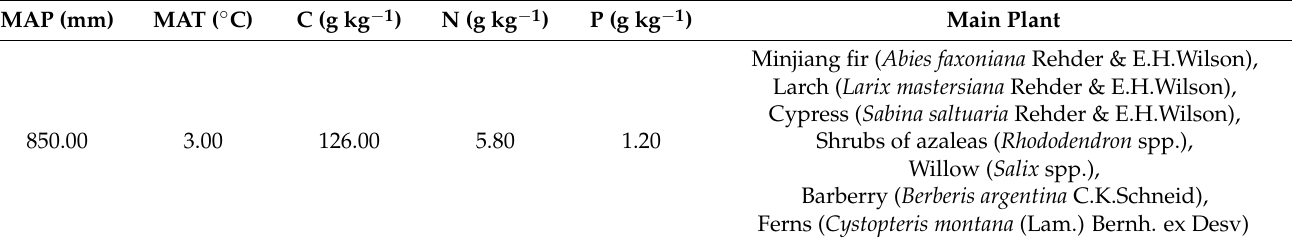
Table 1. Catchment characteristics (MAP, MAT, Soil C, N, P) of the investigated subalpine forest regions. MAP (mm) MAT ( ◦ C) C (g kg − 1 ) N (g kg − 1 ) P (g kg − 1 ) Main Plant Minjiang fir ( Abies faxoniana Rehder & E.H.Wilson), Larch ( Larix mastersiana Rehder & E.H.Wilson), Cypress ( Sabina saltuaria Rehder & E.H.Wilson), 850.00 3.00 126.00 5.80 1.20 Shrubs of azaleas ( Rhododendron spp.), Willow ( Salix spp.), Barberry ( Berberis argentina C.K.Schneid), Ferns ( Cystopteris montana (Lam.) Bernh. ex Desv) MAP: mean annual precipitation; MAT: mean annual temperature; C, N, P values reported were concentrations in the surface soil (0–5 cm of the organic horizon without litter